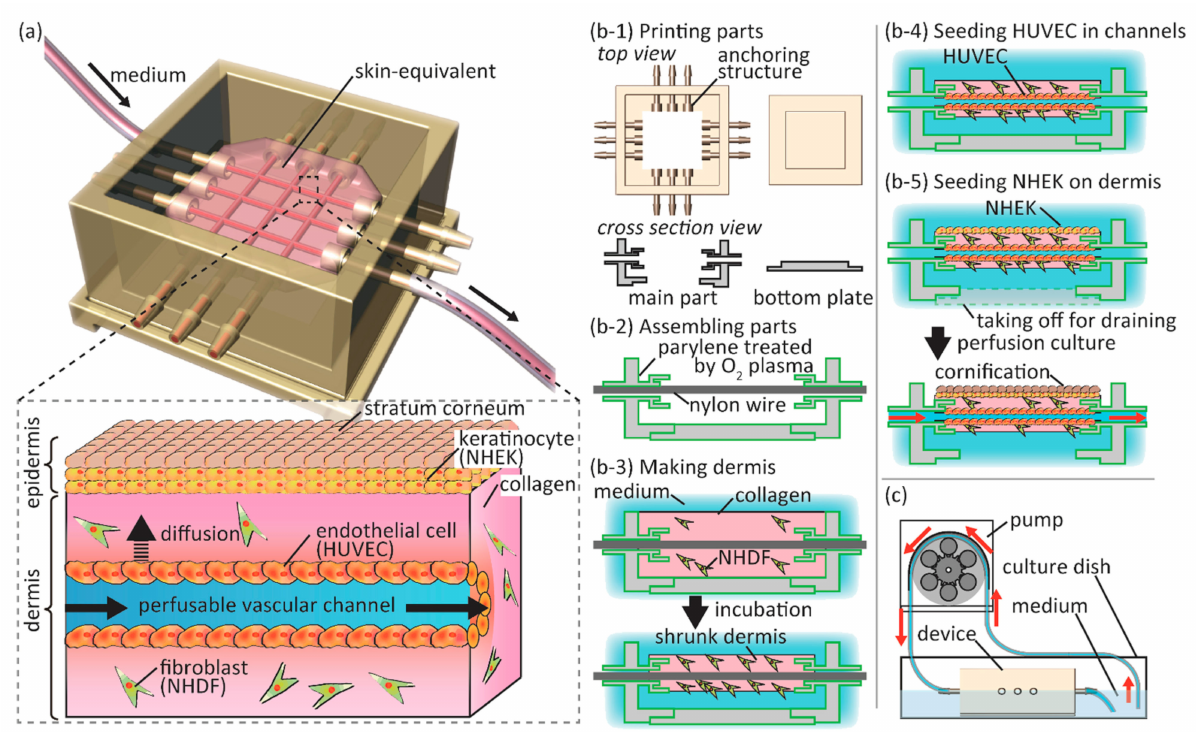
Figure 5. Schematic showing a vascularized, perfusable skin-on-a-chip model. ( a ) Illustration depict- ing the HSE and culture chamber. ( b1 – 3 ) Fabrication of the culture chamber and HSE. ( c ) Perfusion system consisting of the culture chamber, peristaltic pump, and silicone tubes. Adapted with permis- sion from [101], published by Elsevier,